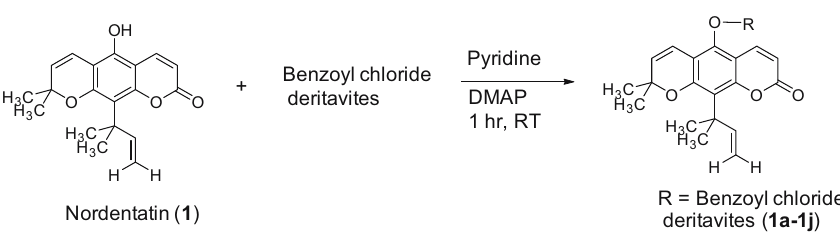
Figure 1: Scheme for the semi - synthesis of pyranocoumarin benzoate